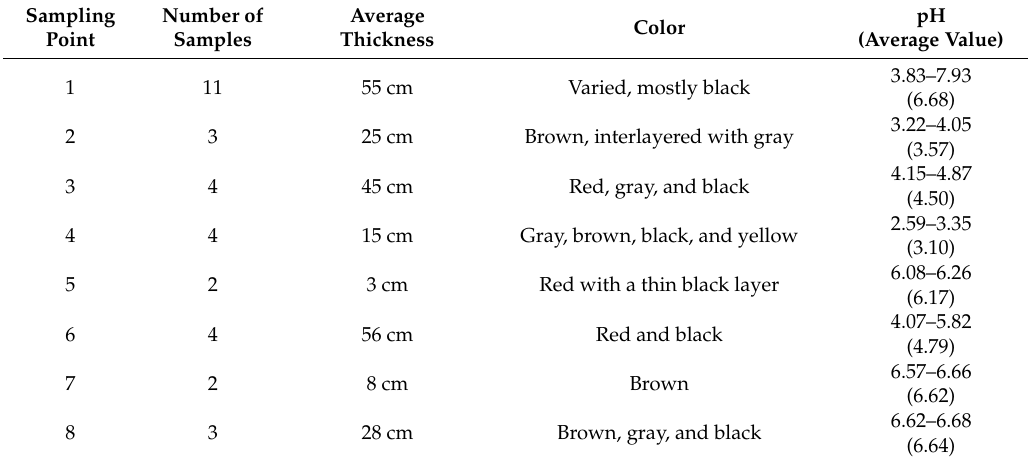
Table 1. Description of each layer of weathered tailings observed on the riverbank of the Nakdong